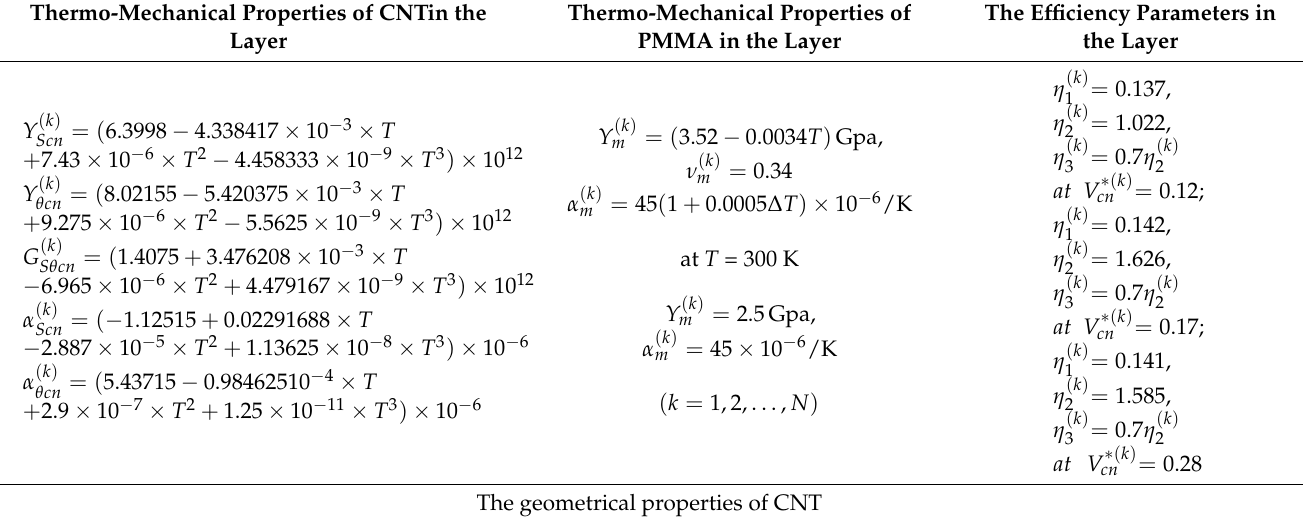
Table 1. Comparison of magnitudes of T CT